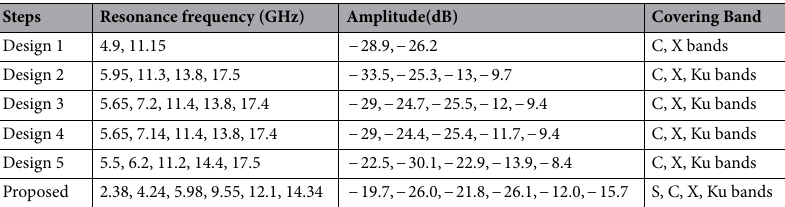
Table 2. Summary of S 21 properties for various design steps of the proposed metamaterial unit